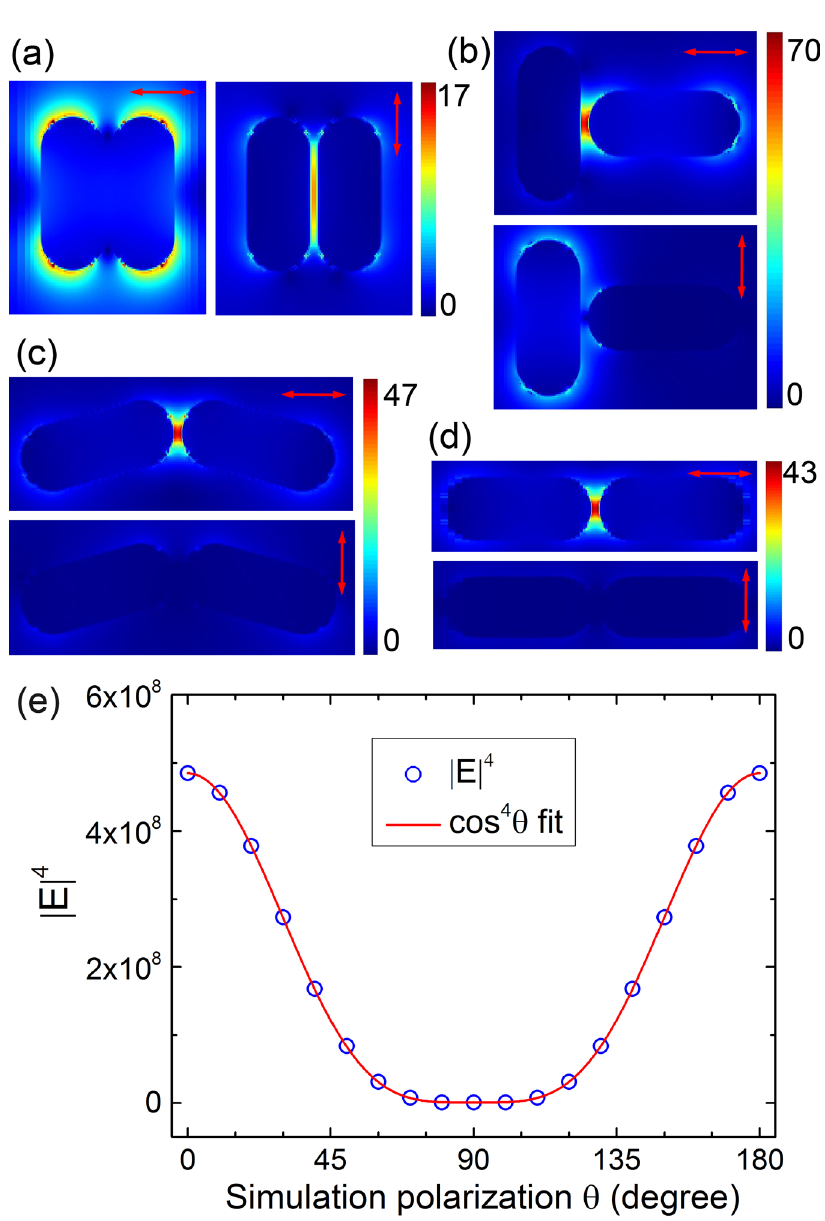
Figure 5. EM field intensity enhancement contours of different GNR dimers for ( a ) side-to-side configuration, ( b ) T-shaped configuration, end-to-end configuration with δ of ( c ) 150° and ( d ) 180° calculated using FDTD. The red arrows indicate the incident polarisations. ( e ) The value of |E| 4 obtained for a dimer with δ = 150° (as in ( c )) at different laser polarisations along with a cos 4 θ fitting